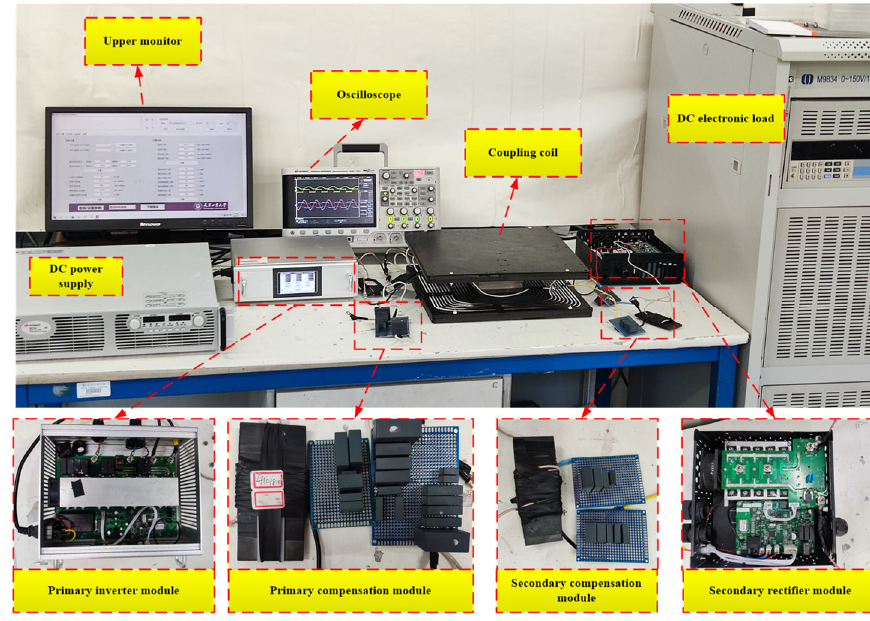
Figure 11. Electric vehicle WPT interoperability experimental system.